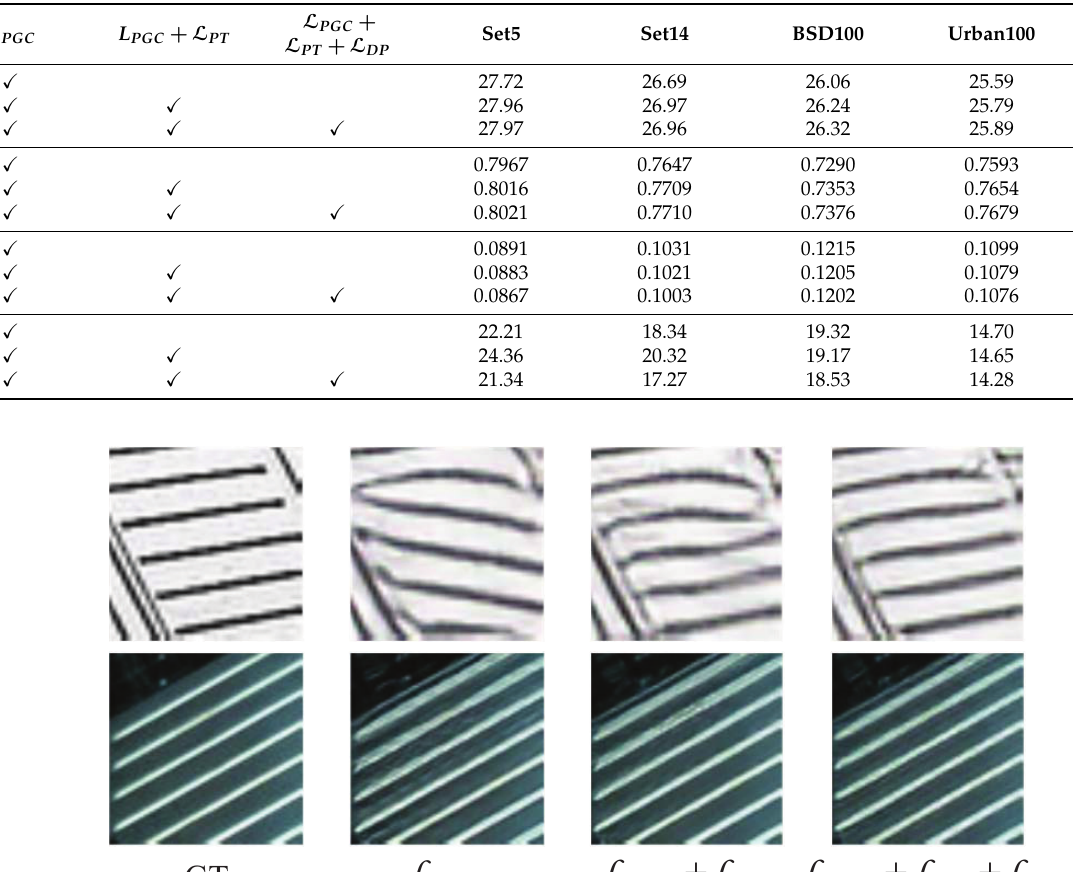
Table 2. Quantitative evaluation of the proposed method under the ablation experiment.